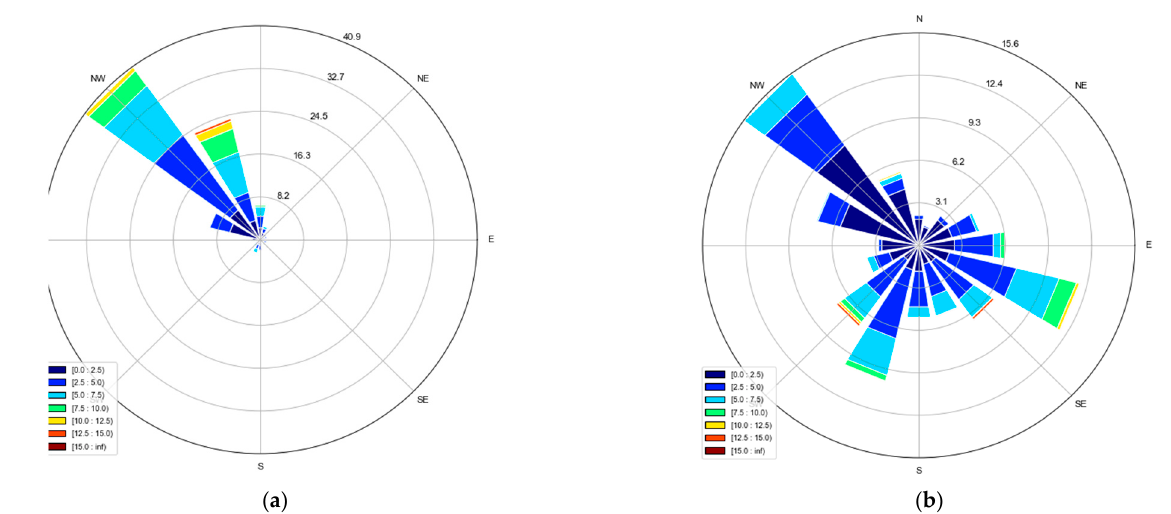
Figure 7. Windroses generated from 30-min averaged wind direction and wind speed observed at the sonic anemometer at 60 m ( a ) in the wintertime (DJF), and ( b ) in the summertime (JJA) [43]. The label bar indicates the wind speed for the given wind direction bin. The radius indicates the percentage of the portion out of total for the given bin.